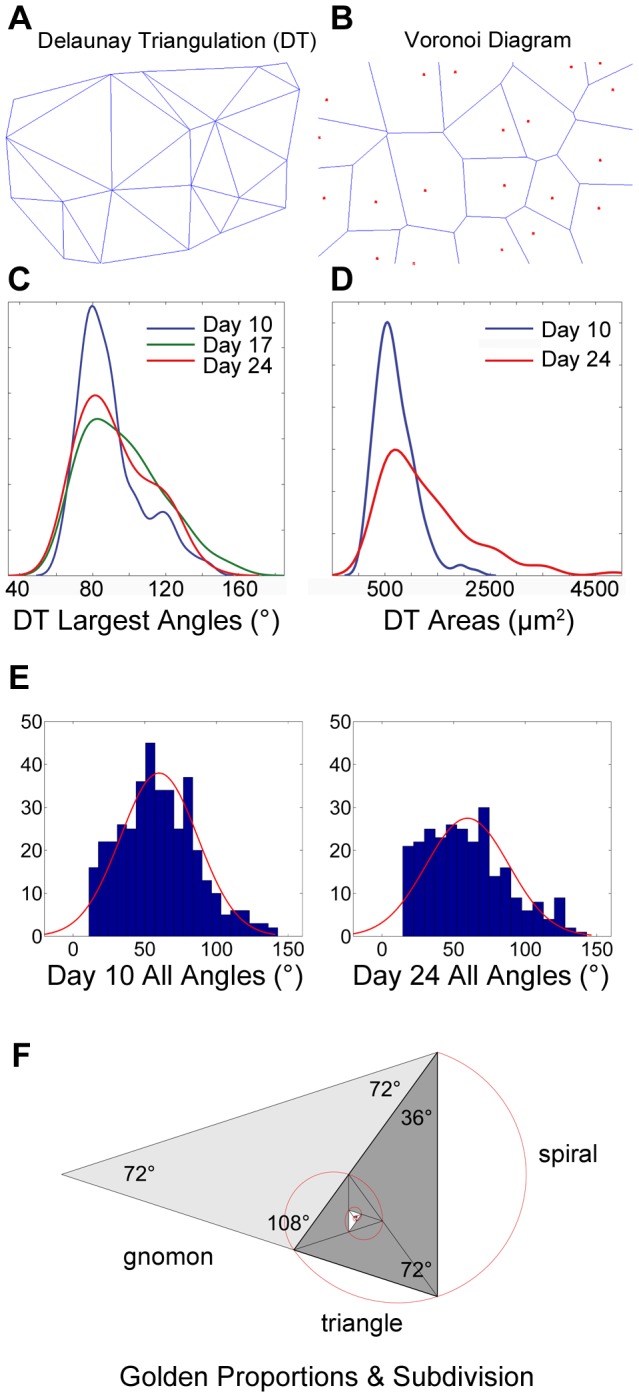
Delaunay Triangulation (DT) and Voronoi analysis based on stomatal centers; KS density plots of largest DT angles and DT areas.A Delaunay triangulation was conducted on each SEM image using the centroids of the stomata, i.e. stomatal pore and surrounding guard cells. B Voronoi diagram using centroids of stomata (centroids shown red) as seen in SEM images. C KS density distribution of the largest angles of the Delaunay triangulation: day 10 (blue), day 17 (green), and day 24 (red). Peaks are consistently around 80°–90°. D KS density distribution plots of DT areas for day 10 (blue) and day 24 (red). Peaks are consistent around 500 µm2. E Histogram with normal distribution fit overlay for all DT angles at day 10 (left) and day 24 (right). F Diagram exemplifies a golden spiral overlaying the golden triangle and golden gnomon.